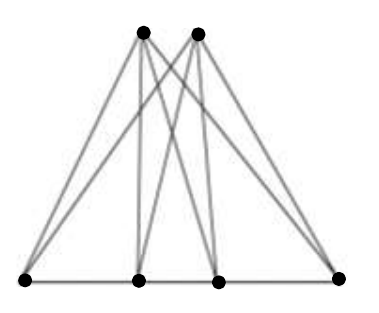
Figure 2: Double fan graph of order 4.